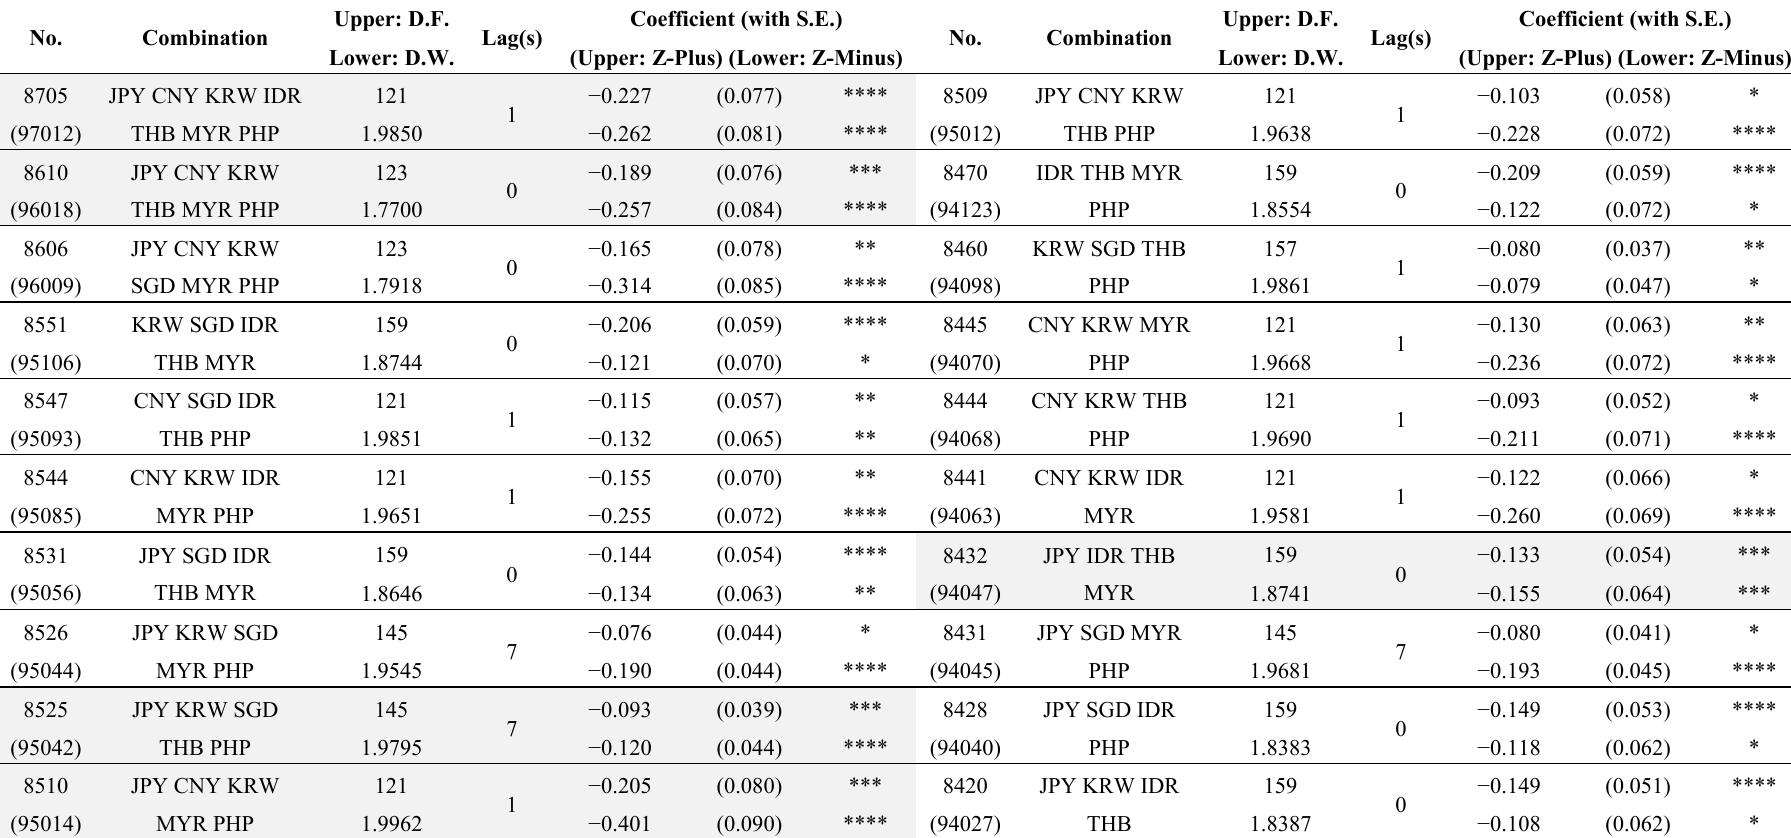
Table 4. M-TAR Unit Root Test for Residuals from Co-integration Estimation (January 1984–June